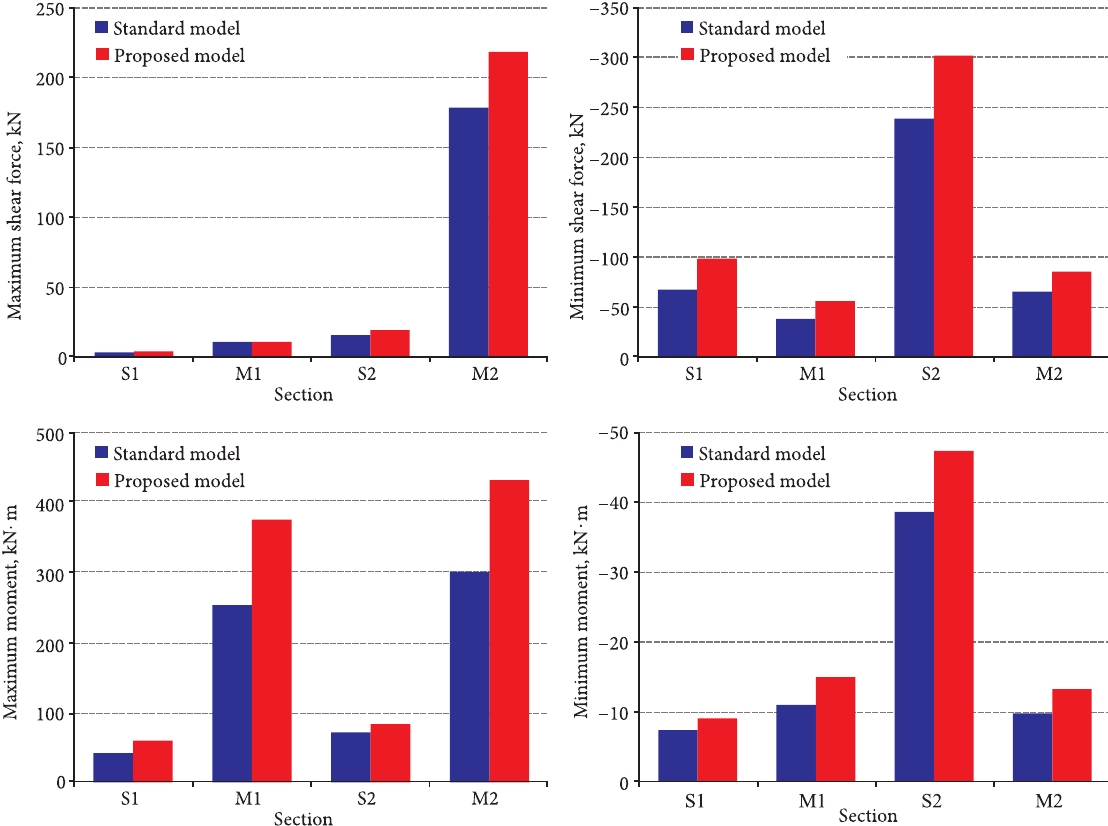
Fig. 16. Comparison of live load effect between code model and measured